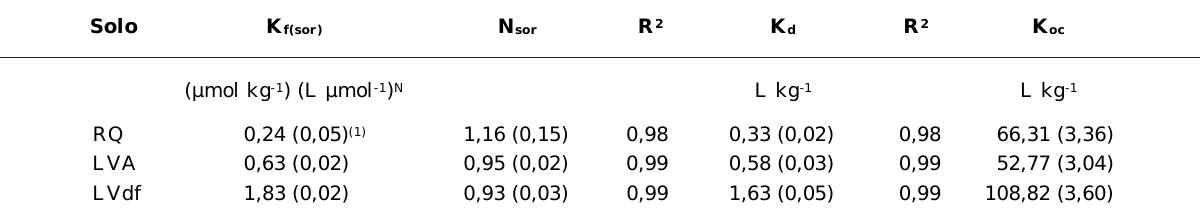
(1) Números entre parênteses referem-se ao